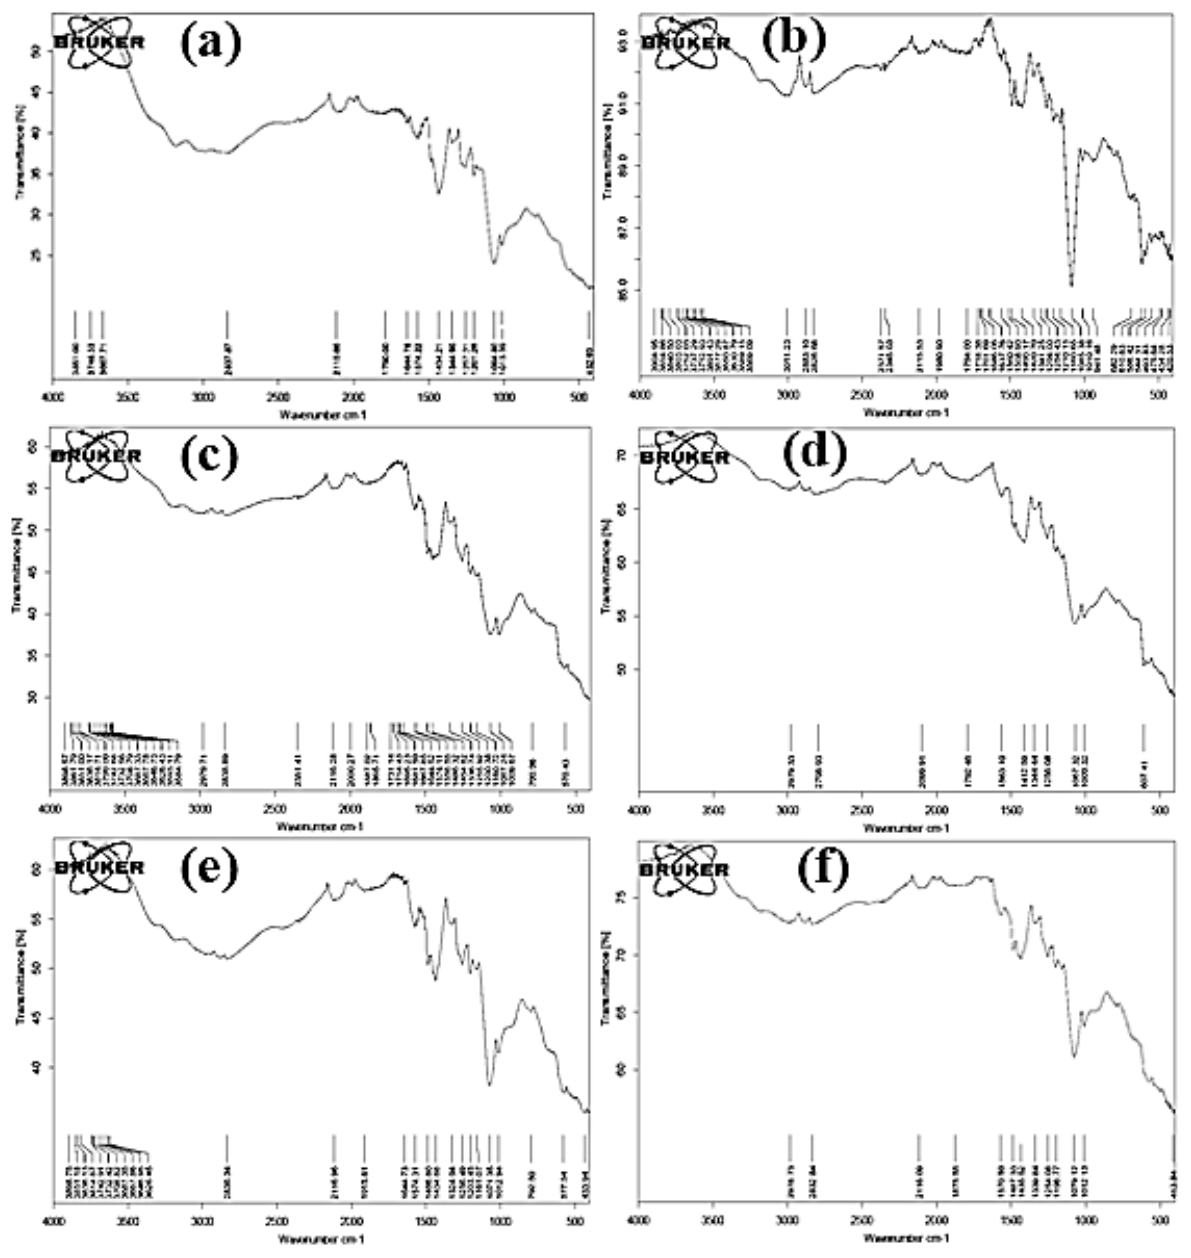
Figure 2. FTIR spectra of: ( a ) POA; ( b ) 2% POA/MMT; ( c ) 4% POA/MMT; ( d ) 6% POA/MMT; ( e ) 8% POA/MMT; ( f ) 12% POA/MMT.